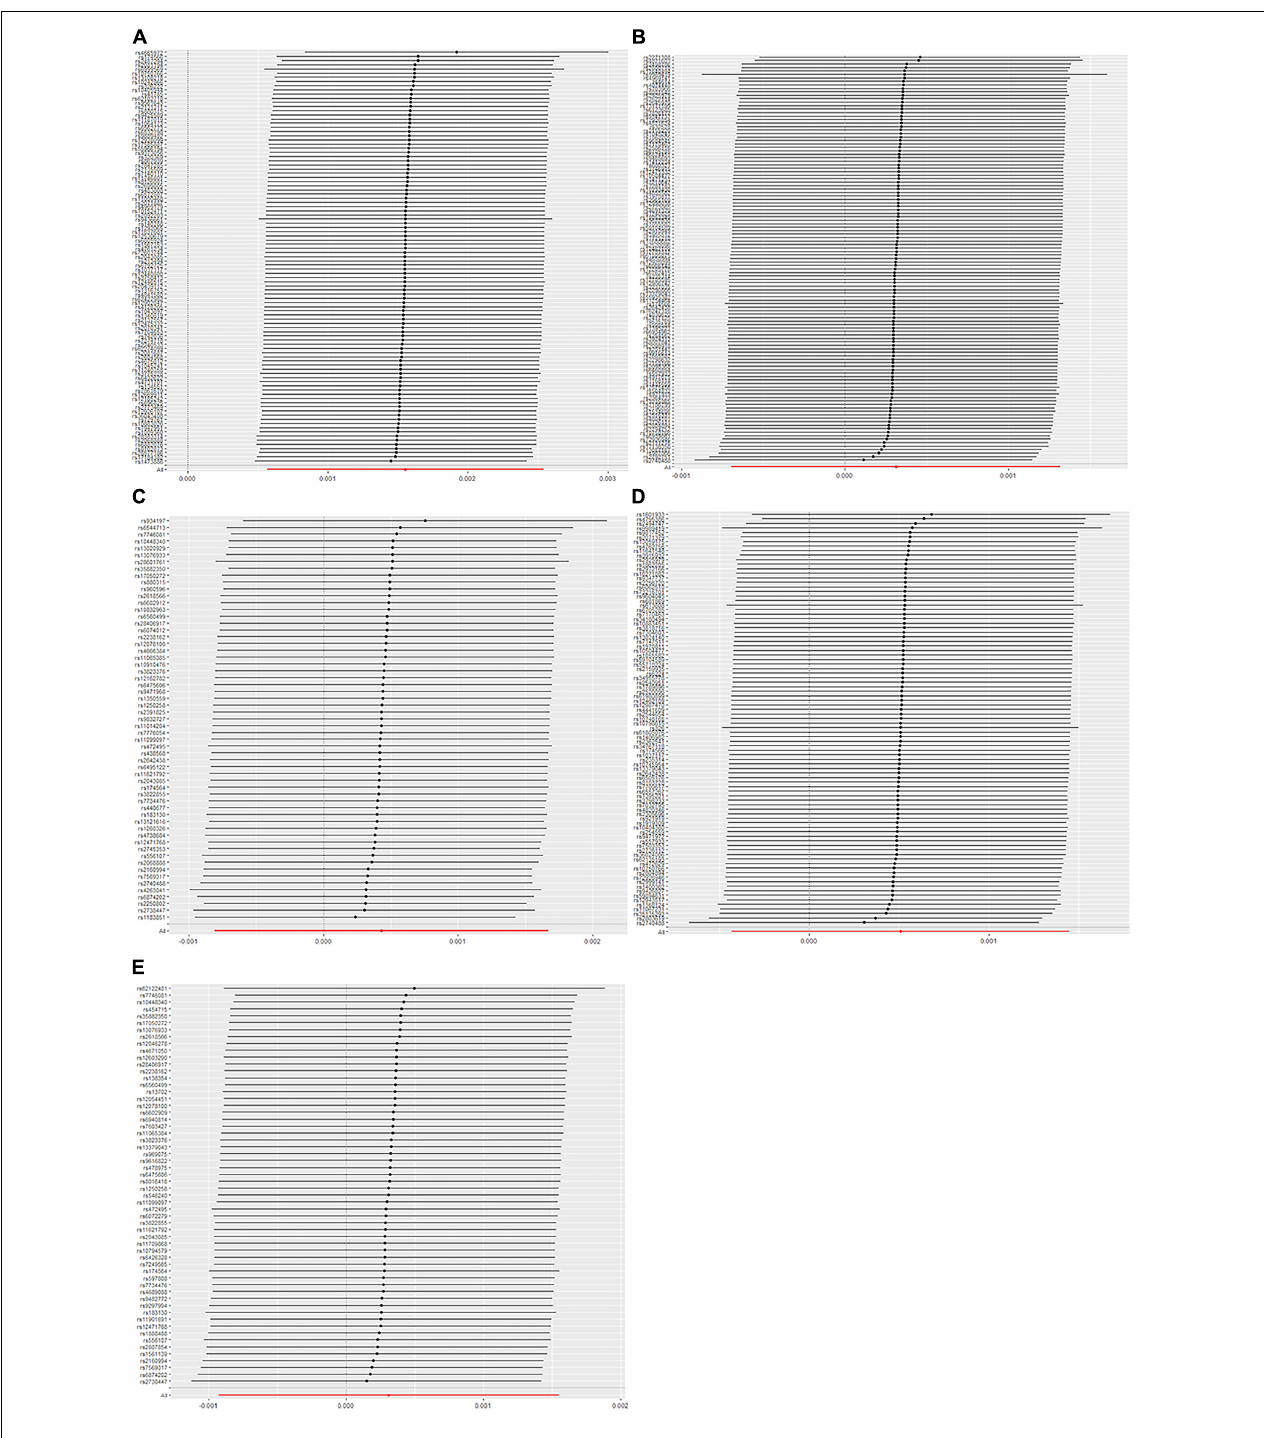
FIGURE 5 | Leave-one-out plot. (A) Triglyceride, (B) high-density lipoprotein, (C) low-density lipoprotein, (D) apolipoprotein A-1, and (E) apolipoprotein B.